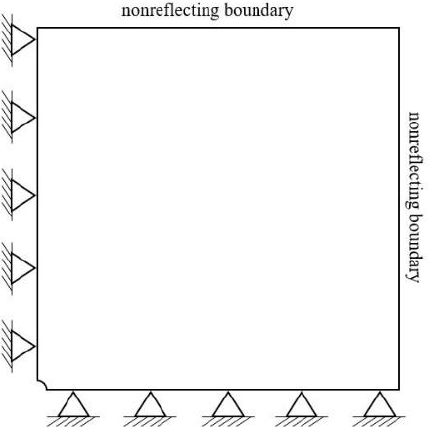
Figure 8. Diagram of numerical calculation model and constraints.